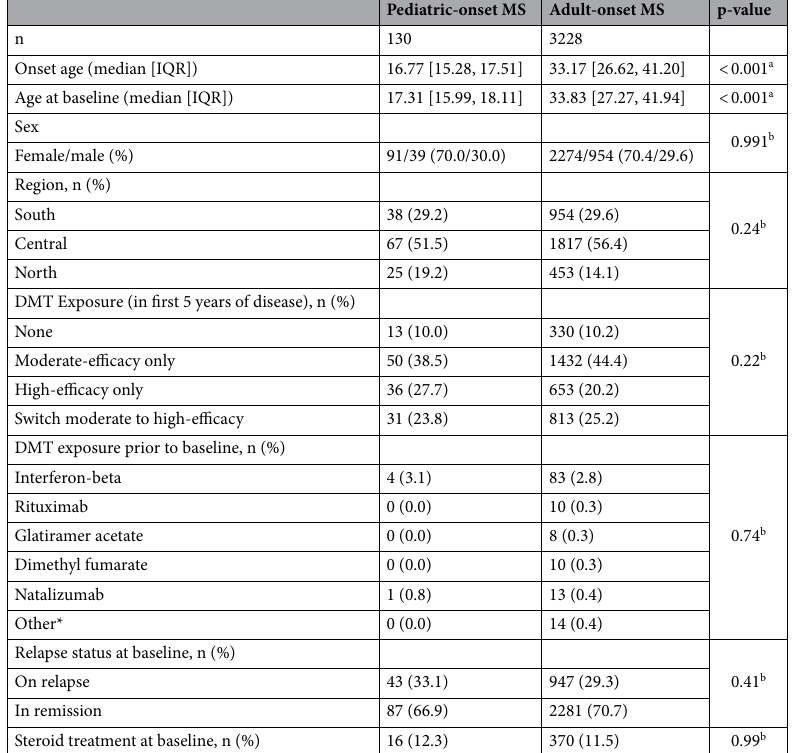
Table 1. Clinical and demographic features of the cohort, comparing the pediatric- and adult-onset MS cases. IQR interquartile range. a By Wilcoxon rank-sum test. b By chi-squared test. *Other DMTs included teriflunomide, ocrelizumab, fingolimod, alemtuzumab, mitoxantrone, and cladribine.